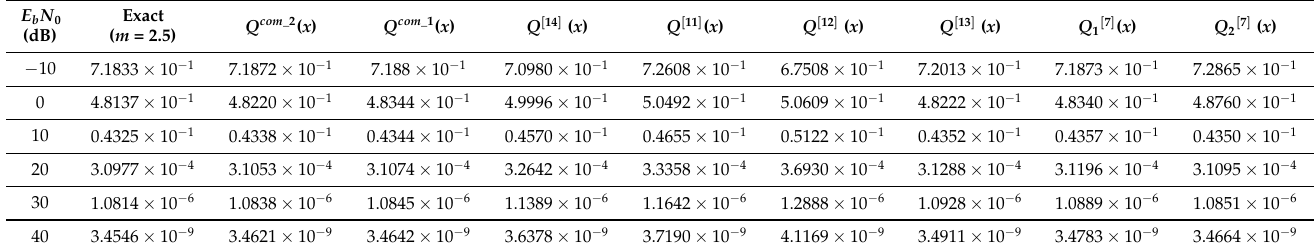
Table 6. Values of the exact and approximated ASEP of the DE-QPSK for parameter m = 2.5.